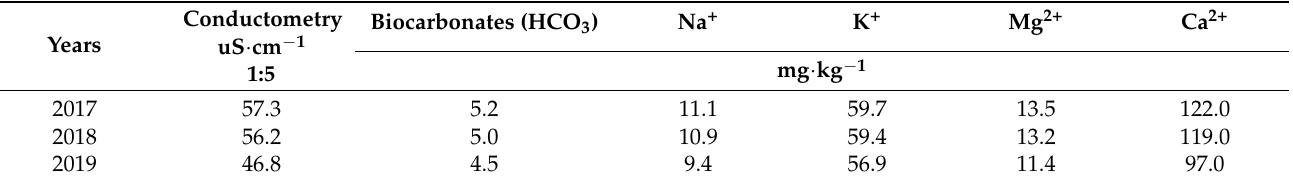
Table 3. Content of water-soluble components.